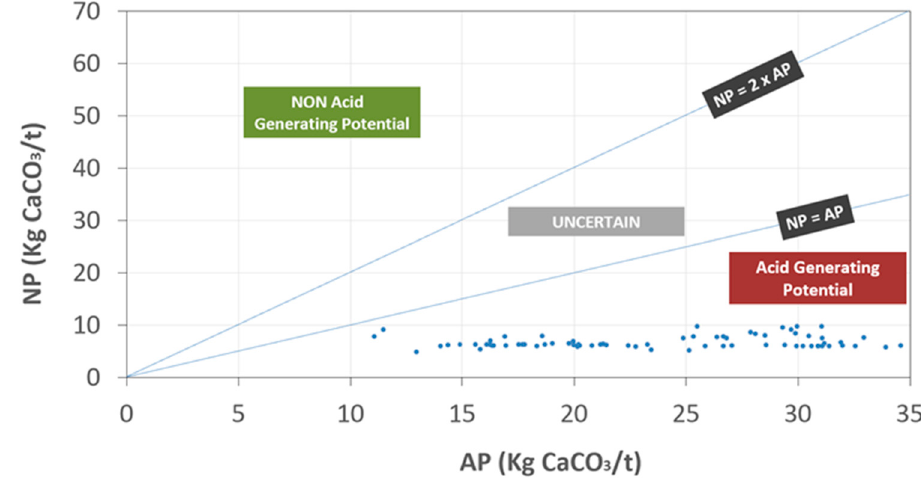
Figure 4. Results of acid generation potential of CMWR.